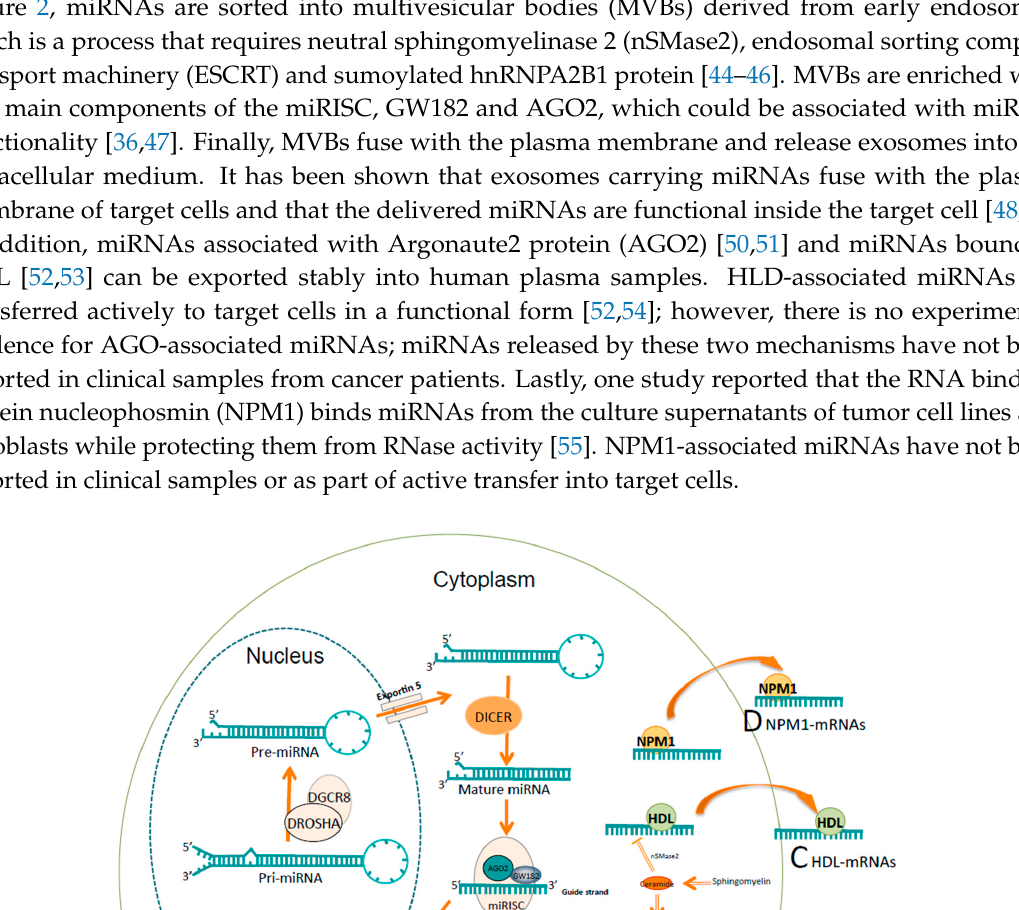
Figure 2. Mechanisms of secretion of miRNAs. ( A ) Secretion of the miRNAs associated with Argonaute2 protein (AGO2); ( B ) Secretion of the miRNAs by exosomes; ( C ) Secretion of the miRNAs associated with high-density lipoprotein (HDL); ( D ) Secretion of the miRNAs associated with the RNA binding protein nucleophosmin (NPM1). ( A ) miRNAs associated with AGO2, a main component of the RISC, can be stably exported into plasma samples. ( B ) miRNAs are sorted into multivesicular bodies (MVBs) derived from early endosomes. This mechanism requires ceramide production on the cytosolic side by neutral sphingomyelinase 2 (nSMase2), ESCRT machinery, and sumoylated hnRNPA2B1 protein, which specifically binds mature miRNAs and controls their loading into MVBs. MVBs are enriched with GW182 and AGO2, which are known to regulate the function of miRNAs. MVBs fuse with the plasma membrane and release exosomes into the extracellular medium. ( C ) miRNAs bound to HDL also can be stably exported into plasma samples via a mechanism repressed by nSMase2. ( D ) NPM1 binds miRNAs from the culture supernatants of tumor cell lines and fibroblasts while protecting them from RNase